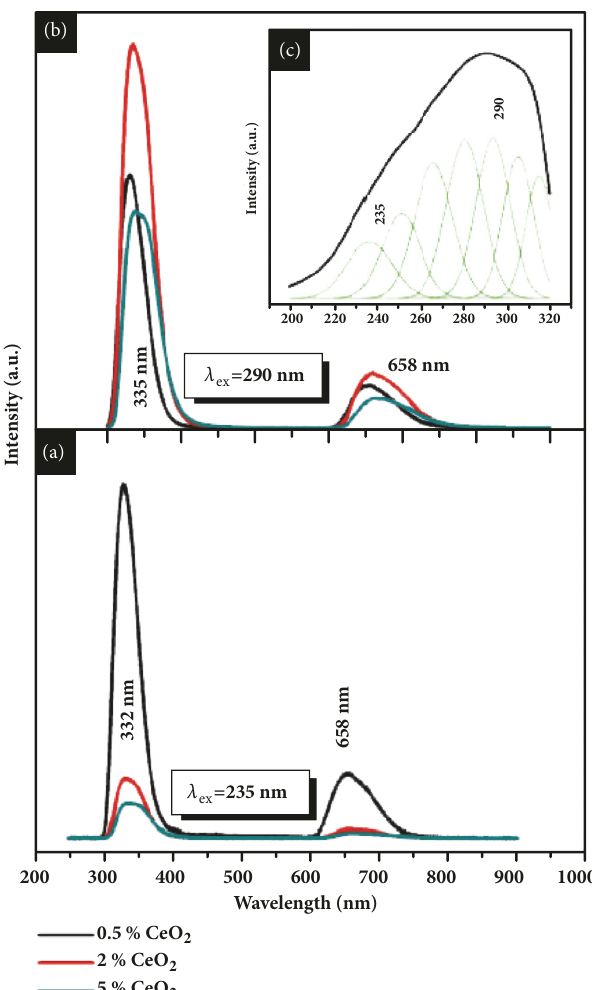
Figure 5: Photoluminescencespectra of CeO 2 -doped glasses: (a) emission at 235nm, (b) emission at 𝜆 ex = 290nm, and (c) excitations at 𝜆 em = 658